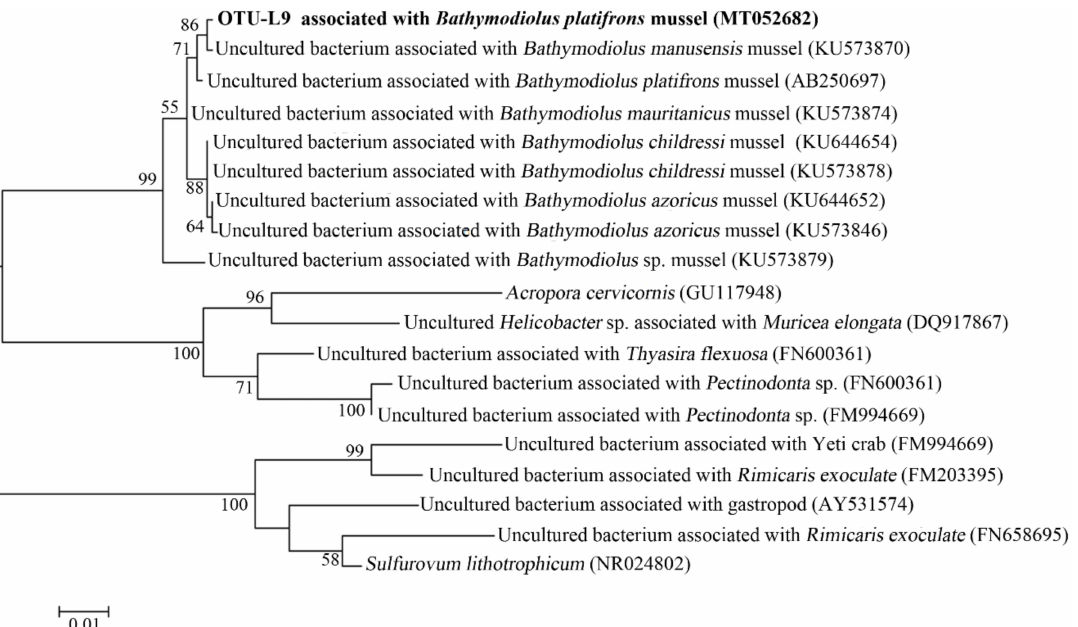
Figure 8. The maximum-likelihood phylogenetic tree based on 16S rRNA gene sequences showing the position of OTU-L3 from this study. Close sequences from NCBI database were selected to construct the tree. GenBank accession numbers are shown in parenthesis. Only bootstrap values (expressed as percentages of 1000 replications) equal or greater than 50% are shown at branching points. Scale bar, 0.005 substitutions per nucleotide position.